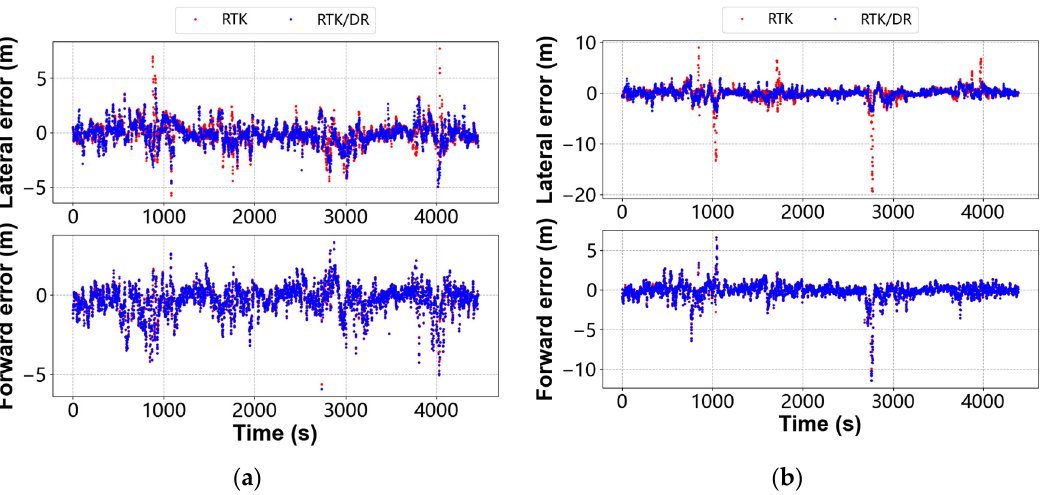
Figure 11. RTK/DR positioning error along lateral and forward direction. ( a ) Smartphone Huawei P30; ( b ) Smartphone Huawei P40. Table 4. Statistics of positioning error RMS of Smartphones Huawei P30 and P40.